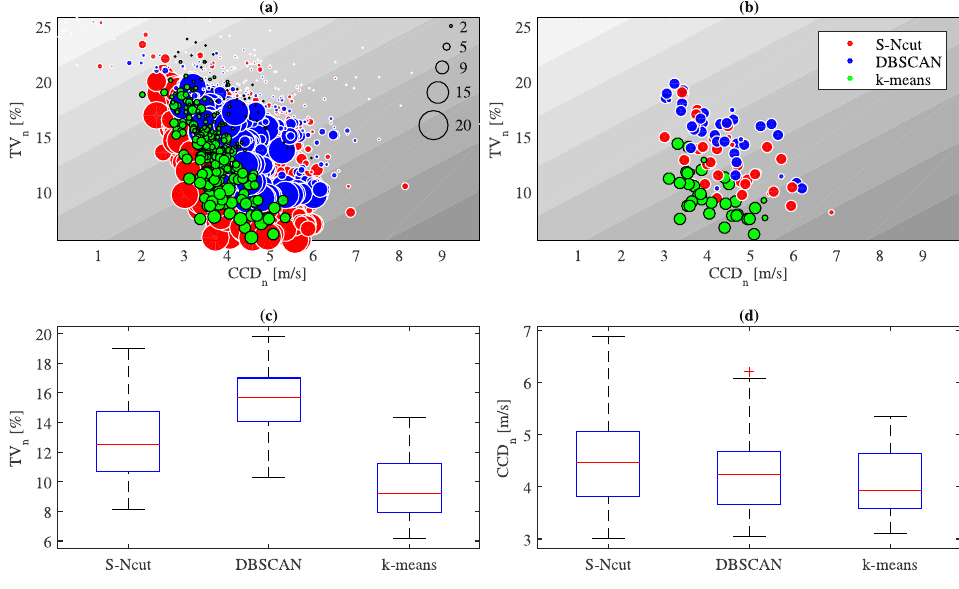
Figure 2. Clustering results for all 35 days. ( a ) Clustering efficiency with respect to the number of clusters ( b ) Clustering efficiency for a number of clusters equal to 9 ( c,d ) TV n and CCD n values (respectively) for all days and 9 clusters. ( a ) Shows that S-Ncut provides the best results compared to the other two methods when the number of cluster is large (above 15). However, when the number of clusters is reduced to 9 ( b ), k-means provides in general the lowest TV n values while leading to similar CCD n values than S-Ncut and DBSCAN. This is confirmed by ( c ) and ( d ) that show TV n and CCD n distribution for all methods when the number of cluster is 9. More interestingly, by comparing ( b ) and ( a ), it appears that k-means with only 9 clusters usually lead to close results compared to S-Ncut with a significant higher number of clusters. So, we define as 9 the optimal number of clusters for all